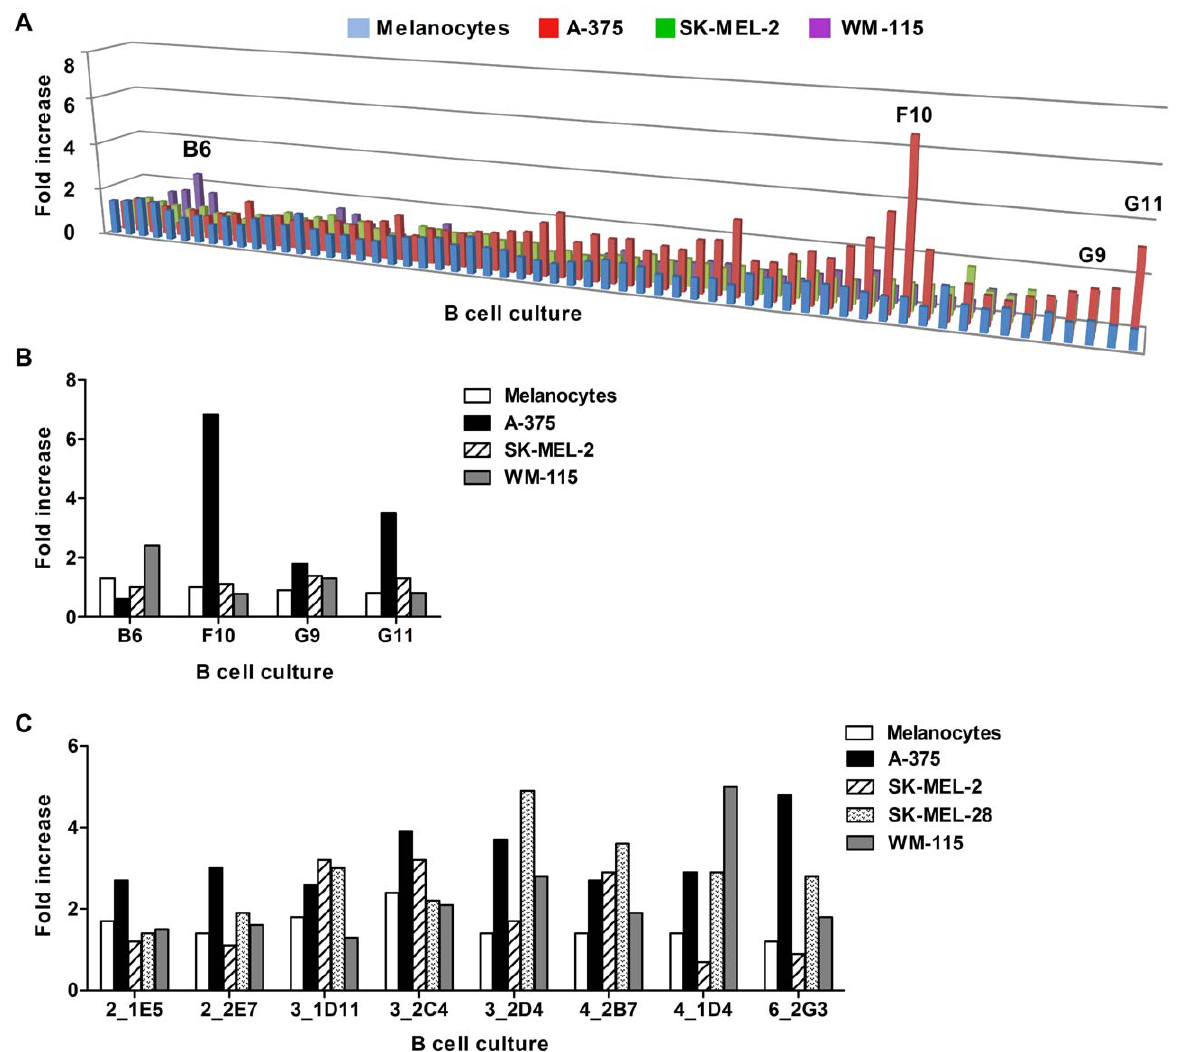
Figure 5. Selection of patient-derived antibodies that recognize melanoma cells. (A) Multiple antibody cultures from one patient (Patient 3, see Table 1) were screened against 3 melanoma cell lines (A-375, SK-MEL-2 and WM-115) and primary melanocytes using the cell-based ELISA. Fold increase values represent optical density (OD) values relative to a negative control antibody. (B) Selected cultures from Patient 3 evaluated in A, which secreted antibodies that bound to the above tumor cell lines are compared to melanocytes. (C) Selected cultures derived from 4 patients were evaluated against 4 melanoma cells lines and compared to melanocytes.